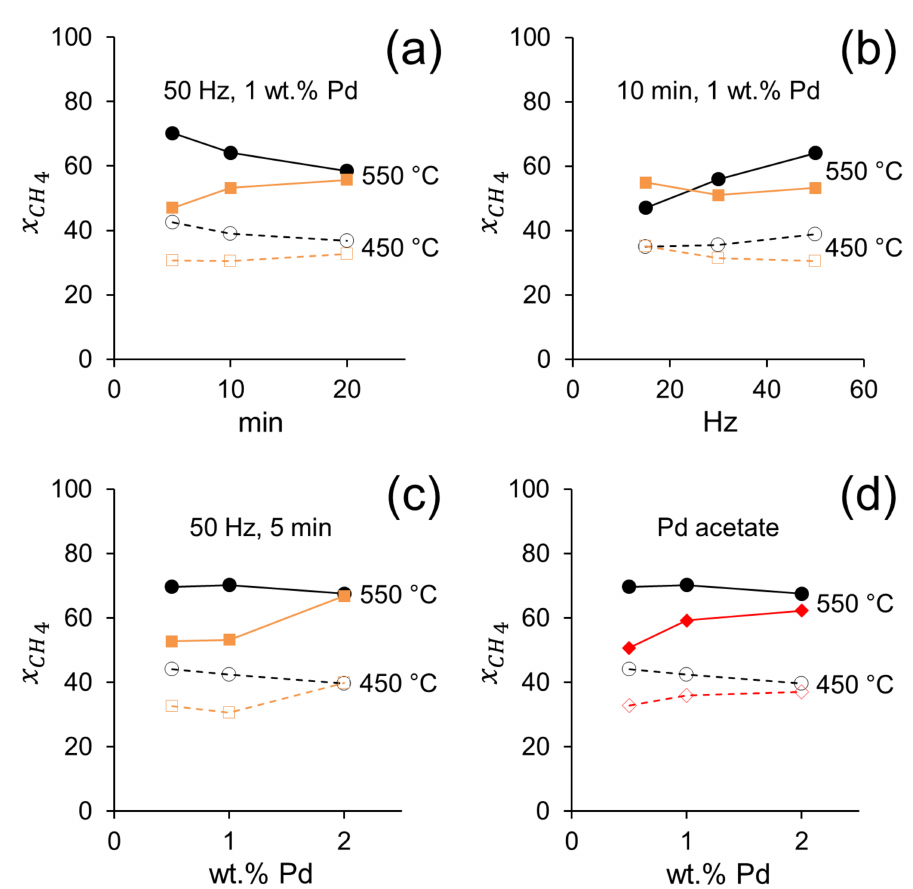
Figure 5. Conversion of methane at 450 and 550 ◦ C on Pd/CeO 2 catalysts prepared by milling CeO 2 and palladium acetate (black) or palladium nitrate (orange) at different milling time ( a ), frequency ( b ) and Pd loading ( c ). Conversion of methane on Pd/CeO 2 prepared by milling CeO 2 and palladium acetate for 5 min at 50 Hz (black) and by incipient wetness impregnation of palladium acetate (red) ( d ). GHSV = 12 × 10 3 h − 1 , F/W = 60 L h − 1 g − 1